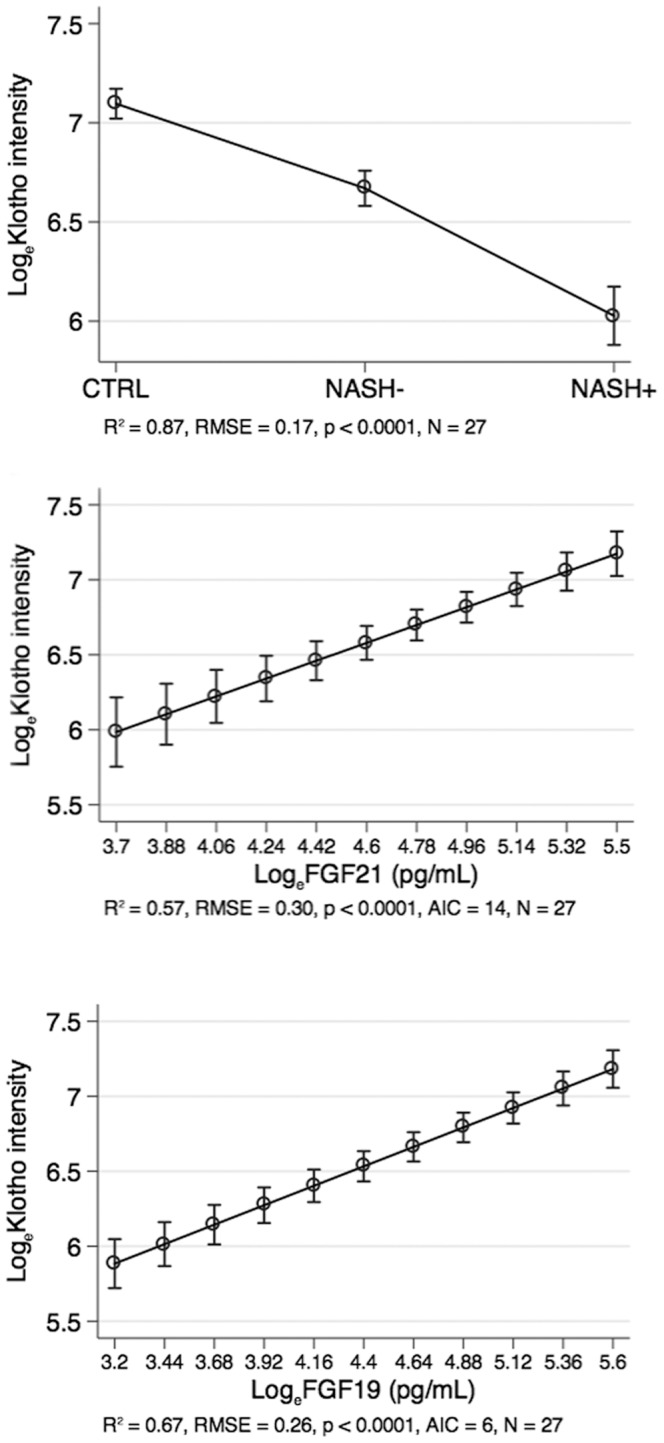
Association between the hepatic expression of Klotho, liver histopathology and serum FGF21 and FGF19.Association of Klotho with histopathology, FGF21 and FGF19 (see text for further details on statistical analysis). Abbreviations: loge = natural logarithm; RMSE = root mean squared error of the estimate; R2 = coefficient of determination; AIC = Akaike information criterion. Circles are means and bars 95% confidence intervals.